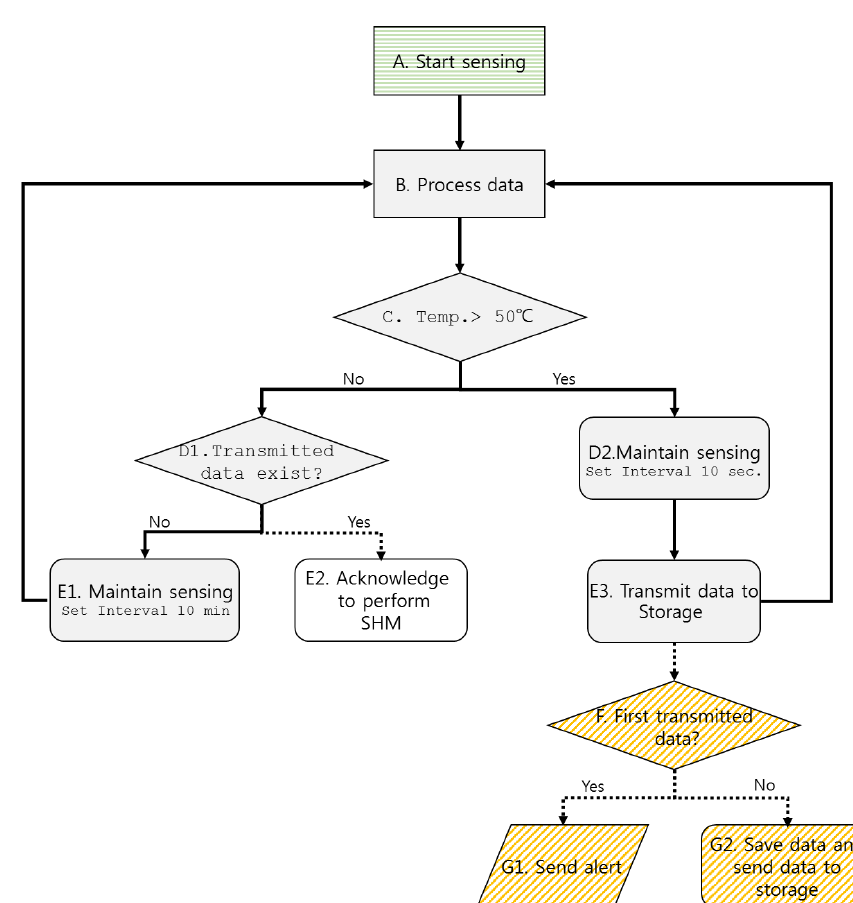
Figure 2. The flow chart of the proposed framework during/after a fire on a building.